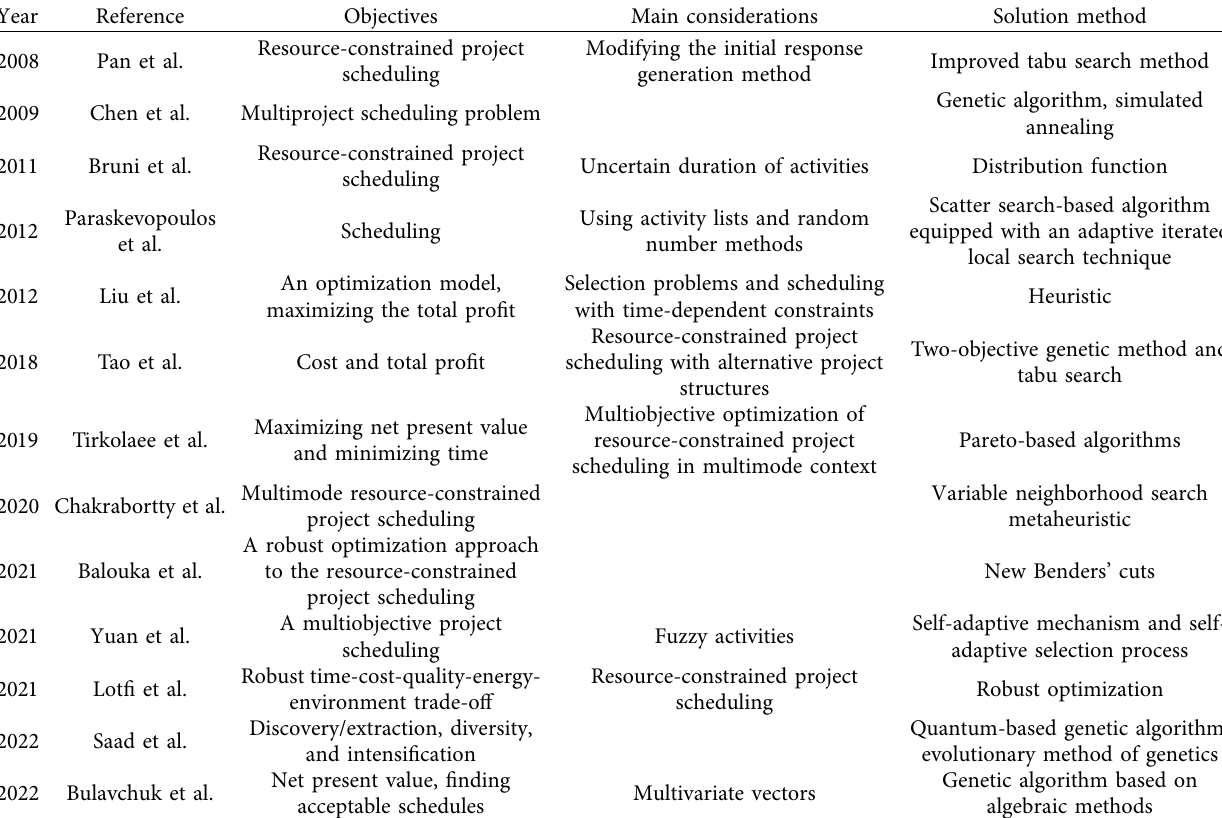
Table 1: Summary of literature